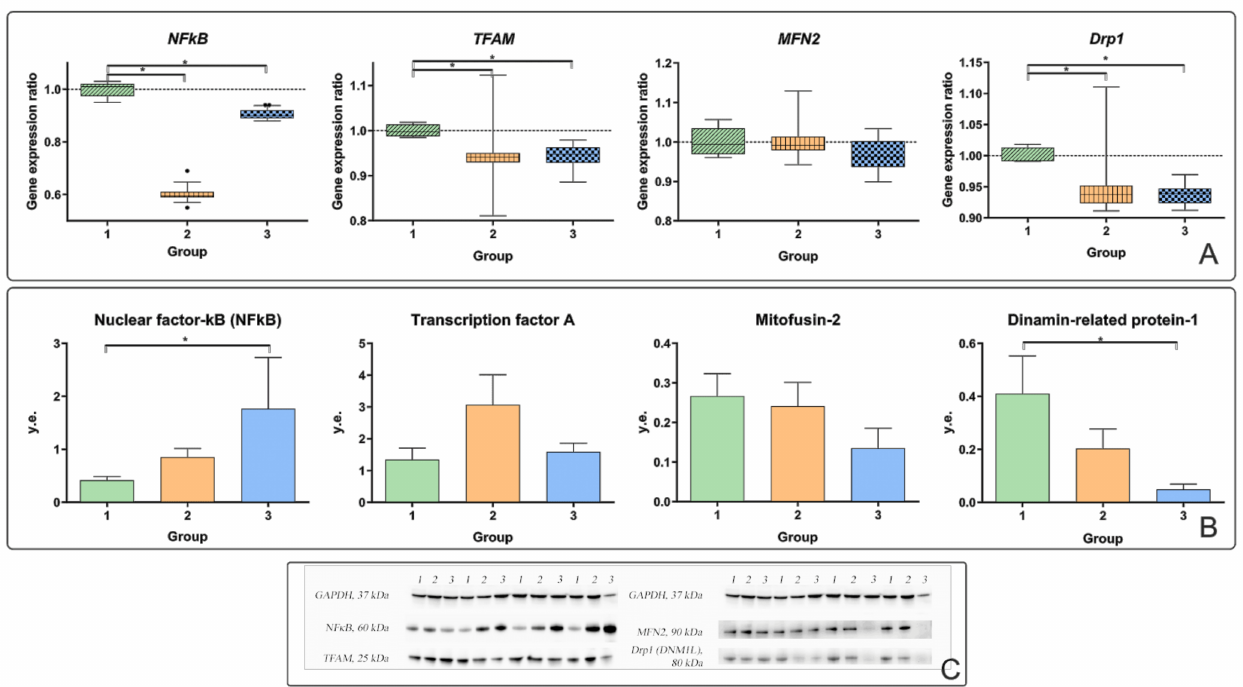
Figure 3. Characteristics of the processes of mitochondrial dynamics in the liver of obese patients with and without T2DM. 1—control group; 2—obesity group without T2DM; 3—obesity group with T2DM; ( A ) gene expression ratios of NFkB, TFAM, MFN2 and DRP1 in liver biopsies; ( B ) nuclear factor-kB (NFkB), transcription factor A (TFAM), mitofusin (MFN2) and dinamin-related protein-1 (DRP1) protein production in liver biopsies; ( C ) Western blot analysis of liver biopsies. The significance was determined using the Mann–Whitney criterion for two independent samples (* p <